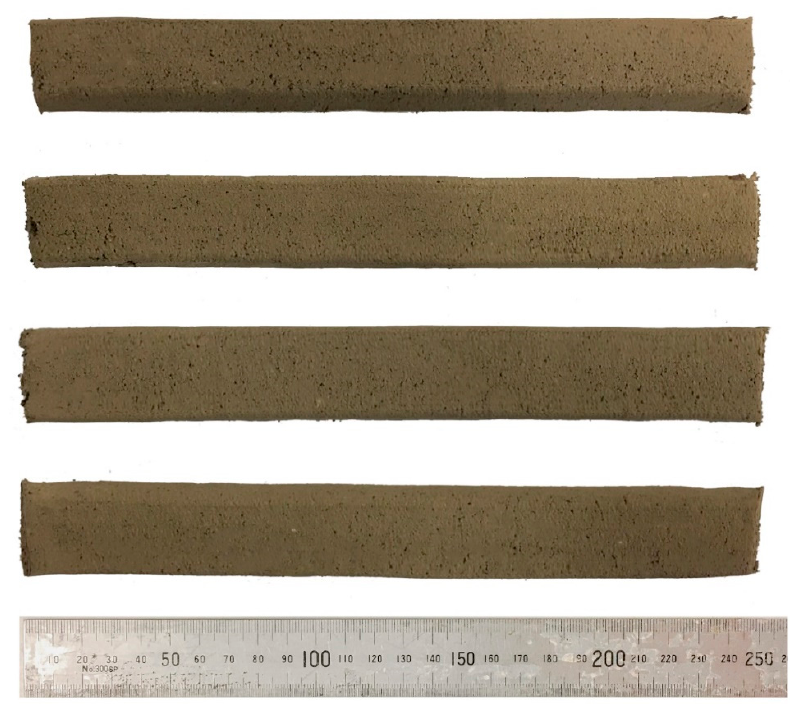
Figure 7. Four 250 mm printed filaments of the “Na-N-2.5” mixture.